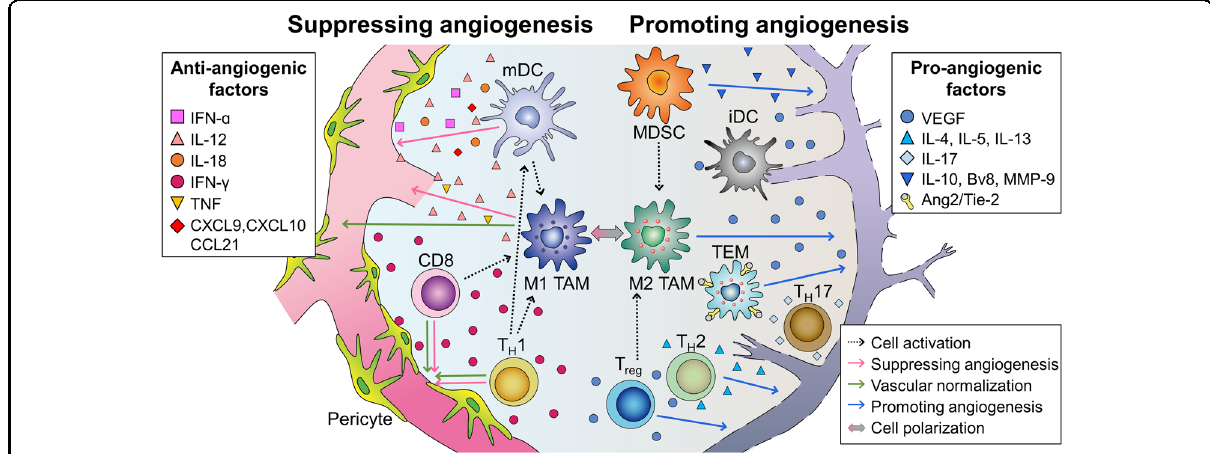
Fig. 2 A variety of immune cells orchestrate tumor angiogenesis. Immune cells directly in fl uence the phenotypes and functions of tumor vessels through various cytokines. Innate immune cells, such as mature dendritic cells (mDCs) and M1-like TAMs, produce cytokines (IFN- α , IL-12, IL-18, or TNF) and chemokines (CXCL9, CXCL10, or CCL21) that suppress tumor angiogenesis. Meanwhile, adaptive immune cells, such as CD8 + T cells and T helper 1 (T H 1) cells, secrete IFN- γ , a potent cytokine that inhibits angiogenesis and induces vascular normalization in the TME. However, immature DCs (iDCs), myeloid-derived suppressor cells (MDSCs), M2 TAMs and Tie2-expressing macrophages (TEM) signi fi cantly promote tumor angiogenesis by secreting VEGF, IL-10, Bv8, and MMP-9. Moreover, T reg , T H 2, and T H 17 cells can also release pro-angiogenic factors such as VEGF, IL-4, IL-5, IL-13, and IL-17. In addition to direct effects on tumor vasculature, immune cells regulate tumor vasculature indirectly by communicating and polarizing with each other. mDC, CD8, and T H 1 cells can skew macrophage polarization away from the M2 to the M1 phenotype. However, MDSCs and T reg cells can reprogram TAMs from M1 to